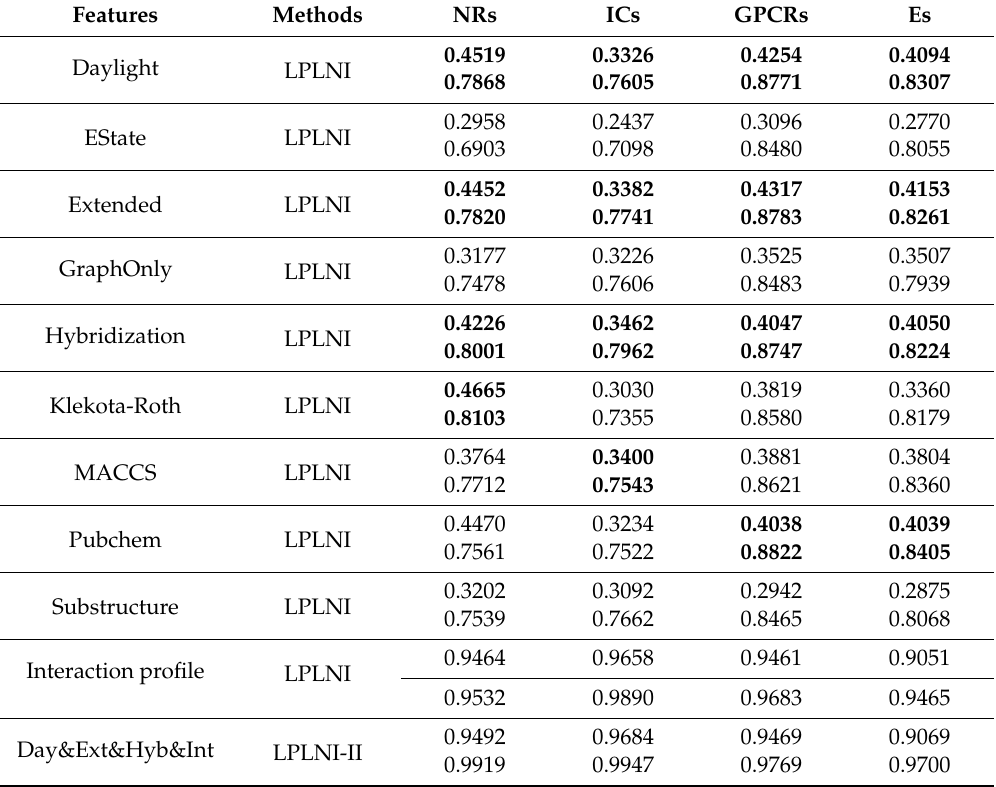
Table 1. Performances of label propagation method with linear neighborhood information (LPLNI) models and LPLNI-II models on the four